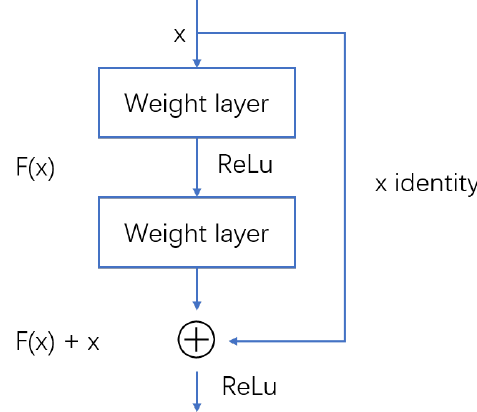
Figure 2. The structure of residual block in